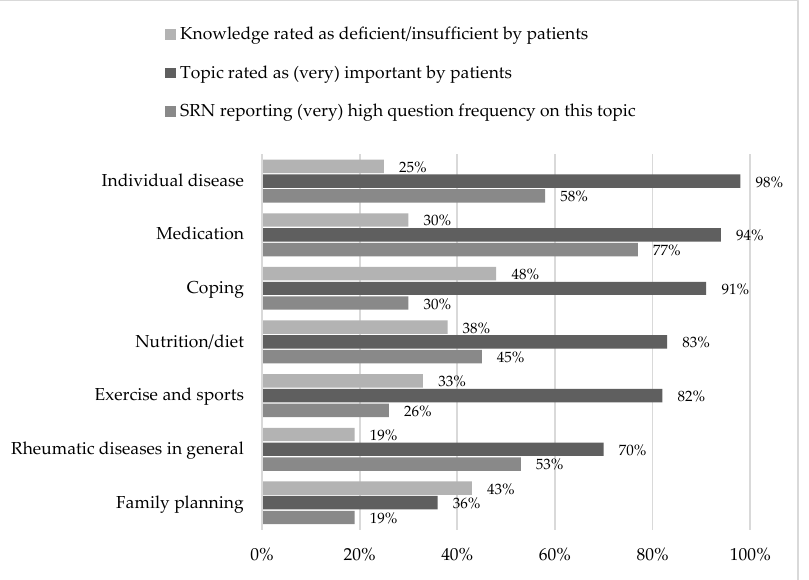
Figure 2. Unmet needs in patient education based on patient-rated topic importance, self-rated education level and SRN-reported question frequency in daily care